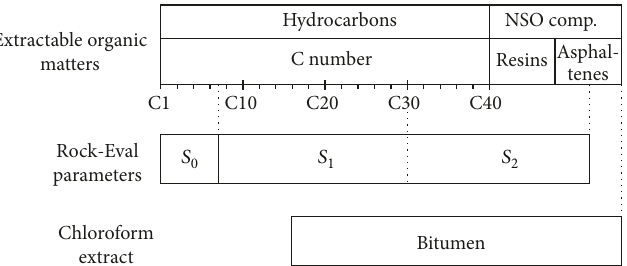
Figure 1: Relationship between pyrolysis parameters 𝑆 1 , chloroform extracts, and residual petroleum (modified after [35]).